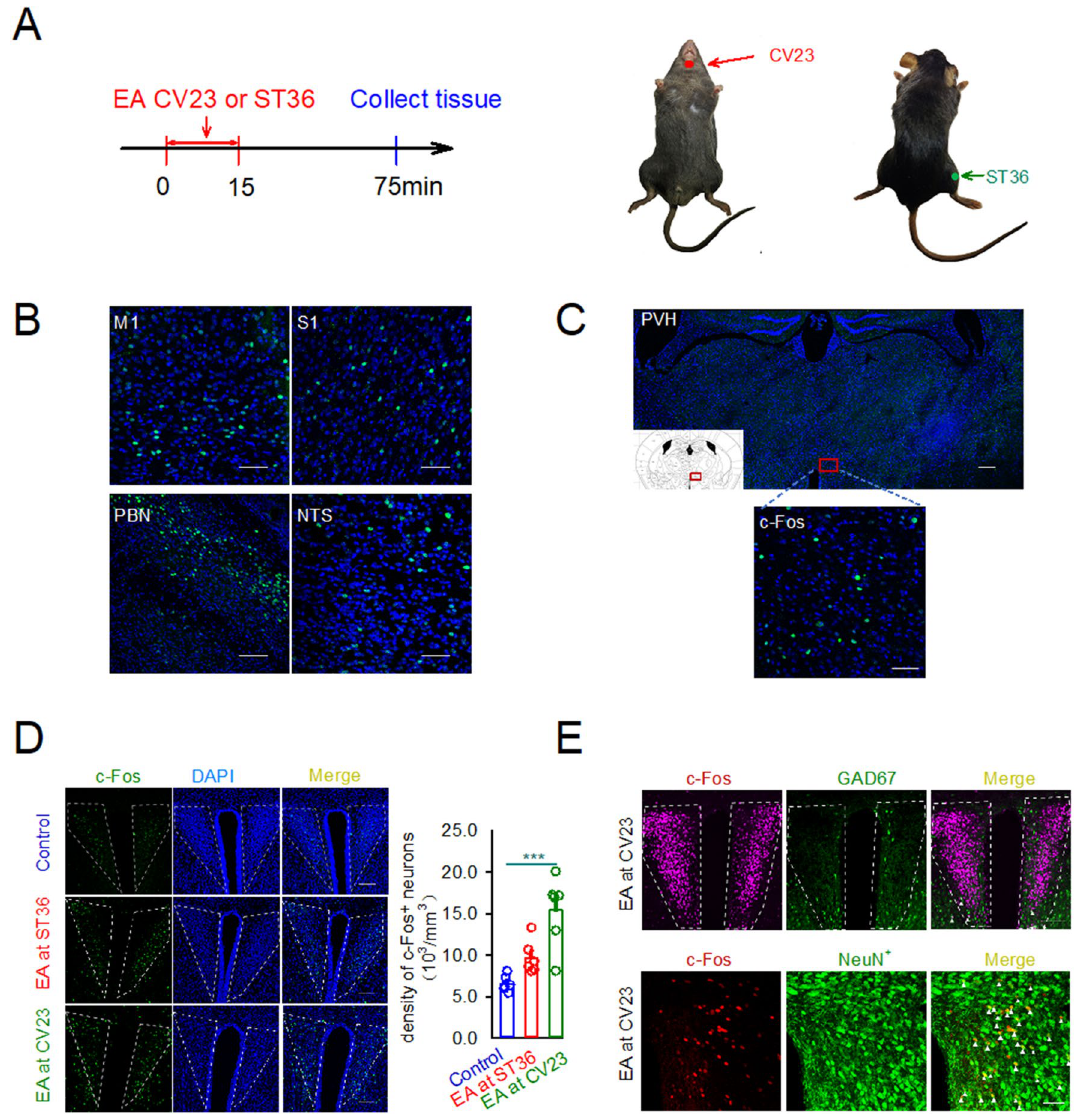
Figure 1. Effects of EA at CV23 and ST36 on c-Fos expression in PVH. ( A ) Schematics of experimental design and the CV23 acupoint and ST36 acupoint. ( B ) Confocal images showing c-Fos expression in M1, S1, PBN and NTS. PBN: Scale bars:100 μm. Others: Scale bars: 50 μm. ( C ) Representative confocal images of the c-Fos positive neurons in PVH activated by the EA Scale bars:1000 μm. Magnification is shown in the bottom, Scale bars: 50 μm. ( D ) Control group (top), ST36 group (middle), CV23 group (bottom). The statistical analysis of the density of c-Fos + neurons in each group.10 3 /mm 3 . Data are shown as the mean ± SEM (N = 6 slices per group). Scale bars: 100 μm ( E ) Top: co-localization of c-Fos with the GAD 67, Scale bars:100 μm, bottom: co-localization of c-Fos with the NeuN, Scale bars: 50 μm. Arrows highlight the co-labeled cells. One-way ANOVA with Tukey’s multiple comparisons test, *** p <